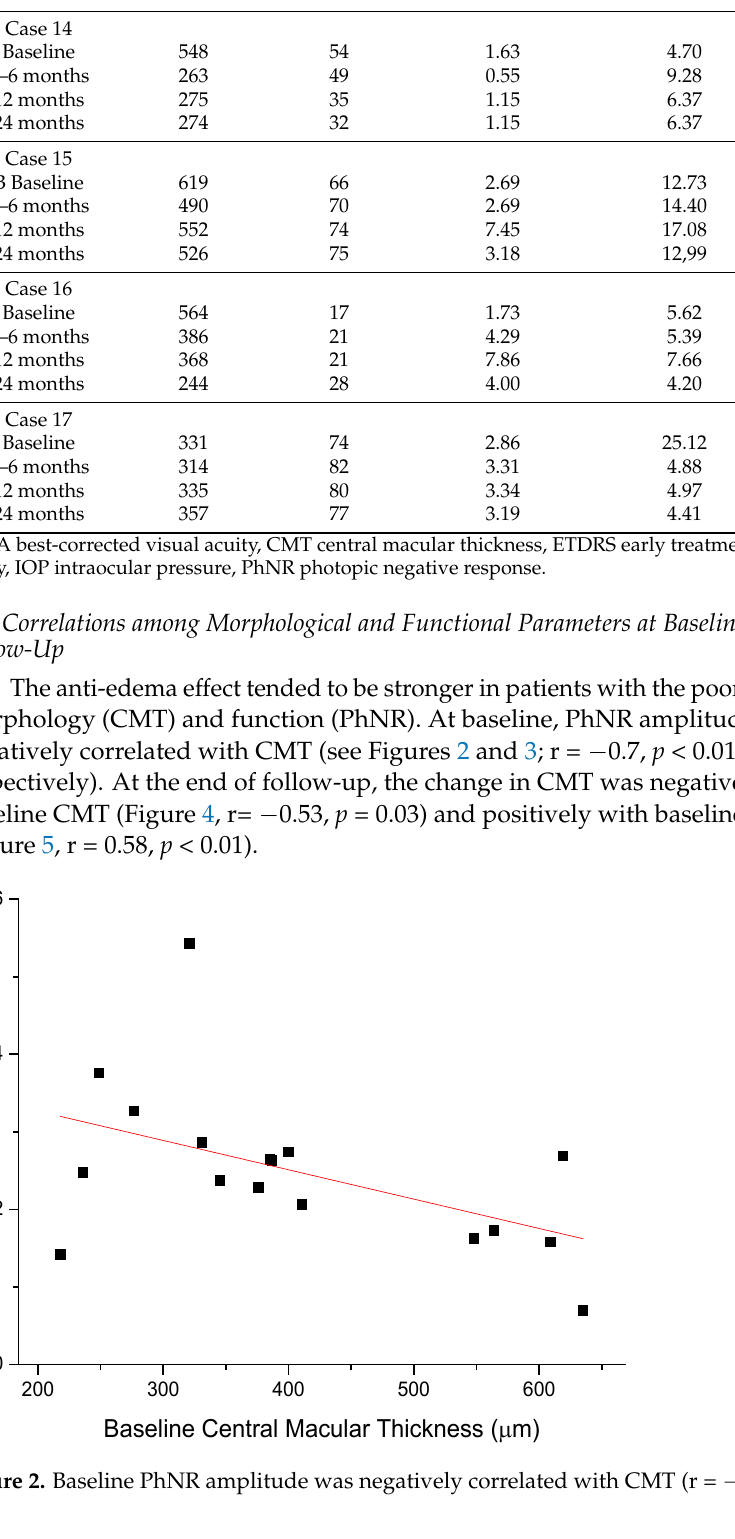
Figure 3. Baseline BCVA was negatively correlated with CMT (r = −0 .5, p < 0.05).